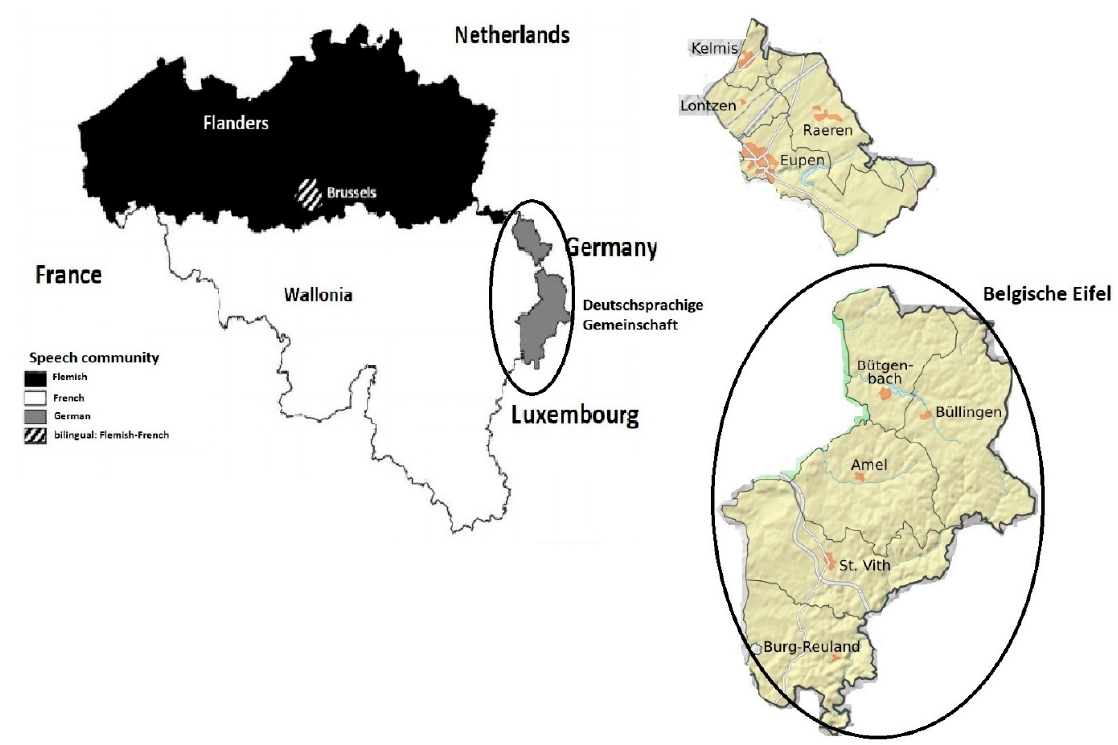
Figure 1. The location of the Belgische Eifel, based on (Verhiest 2015, p.